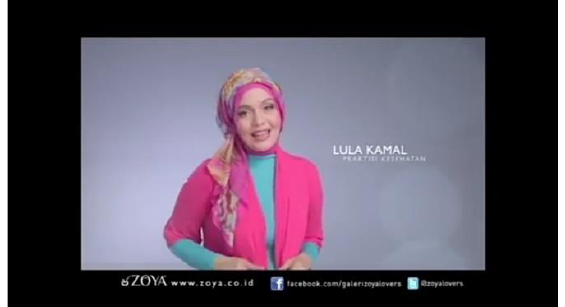
Figure 6: A Medical Doctor Muslim